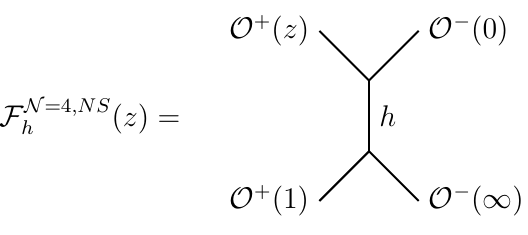
Figure 1 . The chiral-anti-chiral c = 6 NS (cid:6) and intermediate non-BPS primary of weight h O